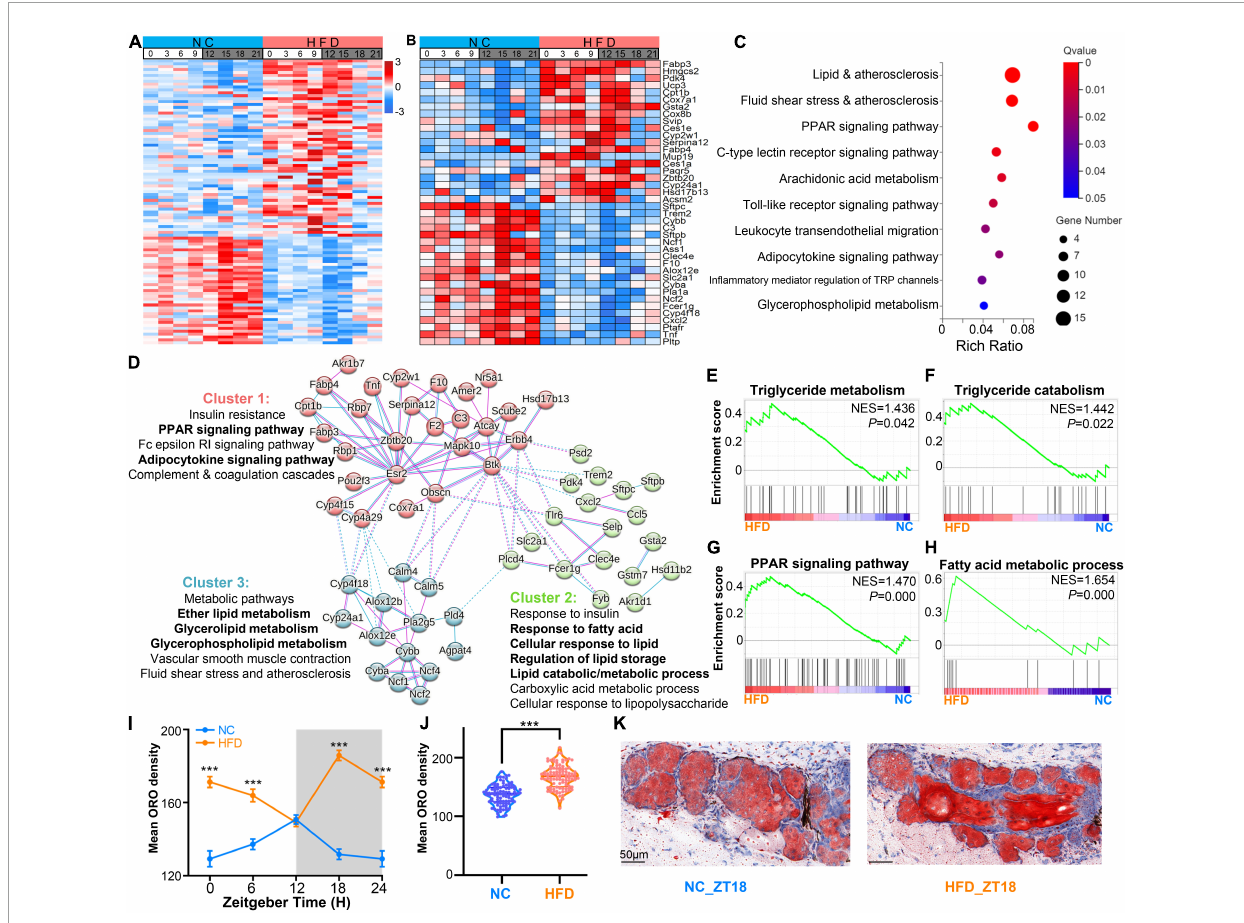
FIGURE6 High-fat diet (HFD)-induced lipid metabolism disorder in MGs. (A) Heatmaps visualizing the expression levels of the differentially expressed lipid-associated genes (fold change ≥ 1.2 or ≤ 0.83, adjust P < 0.05) in MGs between the NC- and HFD-fed mice at various ZT points at 3-h intervals throughout the circadian cycle. The expression levels were indicated by a color bar ranging from blue to red, with the expression range normalized to ± 3. (B) Heatmaps visualizing the expression levels of the top 20 up- and down-regulated DEGs of lipid metabolism-related genes in the MGs between the NC- and HFD-fed mice at various ZT points. (C) The top 10 significant KEGG annotations of 98 DGEs associated with lipid metabolism in the MGs between the NC- and HFD-fed mice ( Q < 0.05). (D) The protein–protein association networks (PPANs) and functional clusters with specific KEGG annotations of lipid metabolism-related DEGs in the MGs between the NC- and HFD-fed mice ( Q < 0.05). (E–H) Enrichment plots for triglyceride metabolism/catabolism, PPAR signaling pathway, and fatty acid metabolic process were enriched specifically in the MGs of HFD-fed mice by GSEA analysis. (I) Temporal changes in lipid droplets in the MGs of NC- and HFD-fed mice at 6 -h intervals. Three to five right-sided MGs were randomly selected from each NC- and HFD-fed mouse. n = 6 mice per group per sampling time point. Student’s t -test was performed for each ZT point in the NC- and HFD-fed mice. *** P < 0.001. The gray shading indicates the dark phase. (J) Average lipid droplet accumulation in the MGs of NC- and HFD-fed mice. n = 24 mice per group. Student’s t -test between the NC- and HFD-fed mice. *** P < 0.001. (K) Representative